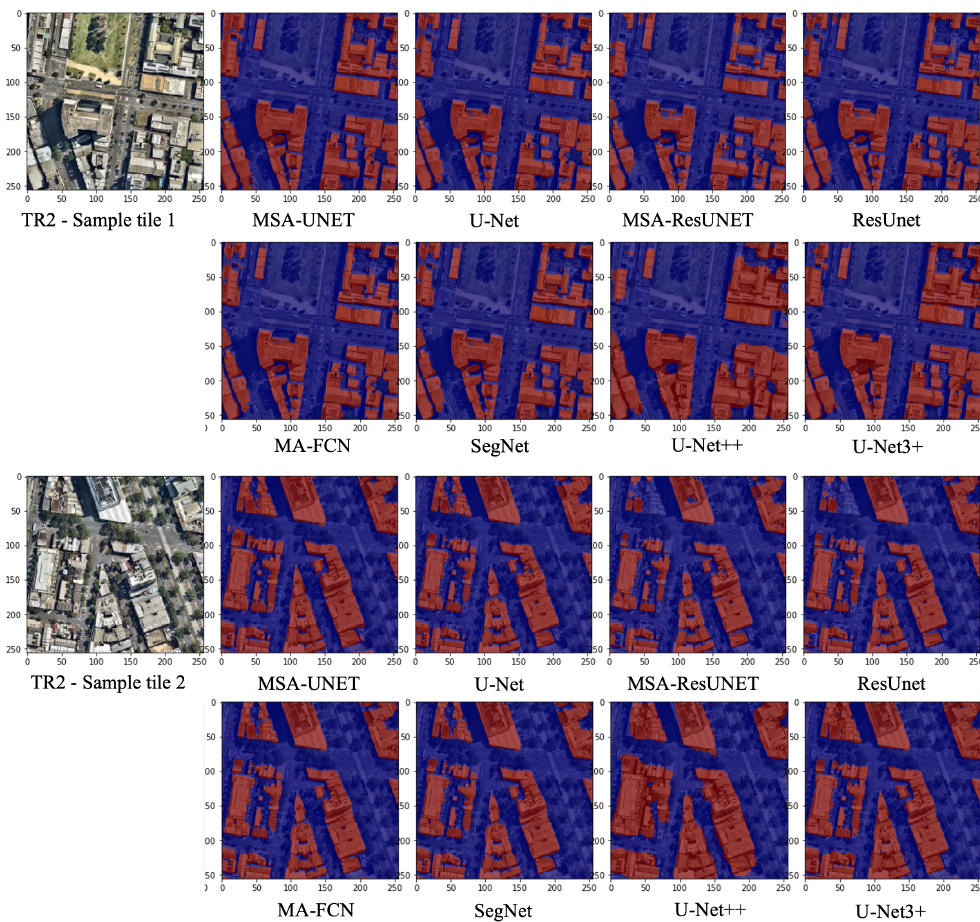
Figure 7. Sample results from the MSA-UNET, U-Net, MSA-ResUNET, ResUNET, MA-FCN, and SegNet, U-Net++, and U-Net3+ on the Melbourne Building dataset (TR2). The left-most images are two different samples from TR2 followed by the corresponding outputs from the eight base